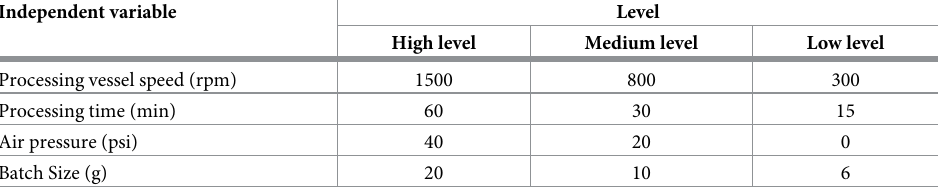
Table 2. List of independent variables with their feasible investigational ranges that were used in optimisation DOEs. Independent variable Level High level Medium level Processing vessel speed (rpm)